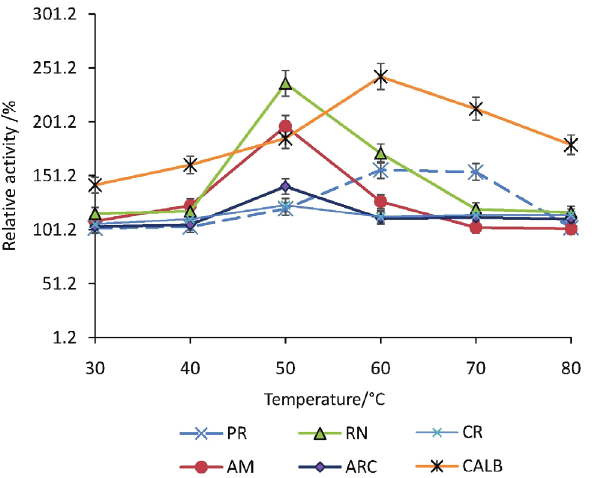
Fig. 4b – Relative activity of lipases at different tempera- tures in the presence of 40 % NADES3 compared to the initial activity after incubation for one hour